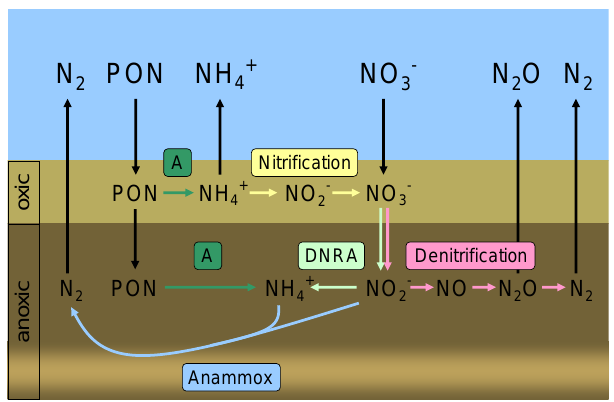
Fig. 1. The benthic microbial nitrogen cycle in aquatic ecosys- tems with nitrate present in the water column. Black arrows in- dicate the predominant routes of net transport of particles or so- lutes between water and sediment. Colored arrows indicate conver- sions along individual nitrogen-cycle pathways. PON: particulate organic nitrogen, A: ammonification, DNRA: dissimilatory nitrate reduction to ammonium, Anammox: anaerobic ammonium oxida- tion. Boxed labels on the left demarcate oxic and anoxic layers within the sediment. To simplify matters, the pathway nitrogen fix- ation (N 2 → NH + ) is 4